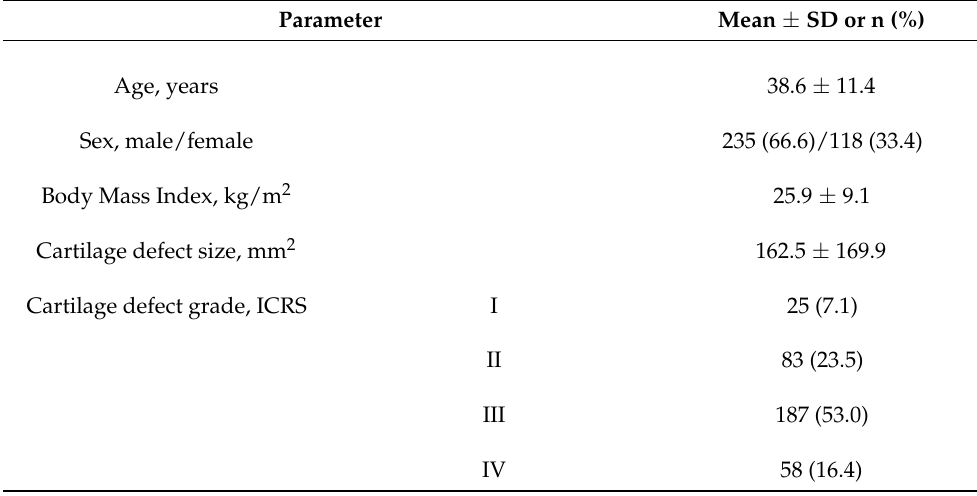
Table 1. Baseline demographics. Baseline demographics and defect-specific characteristics (ICRS, International Cartilage Repair